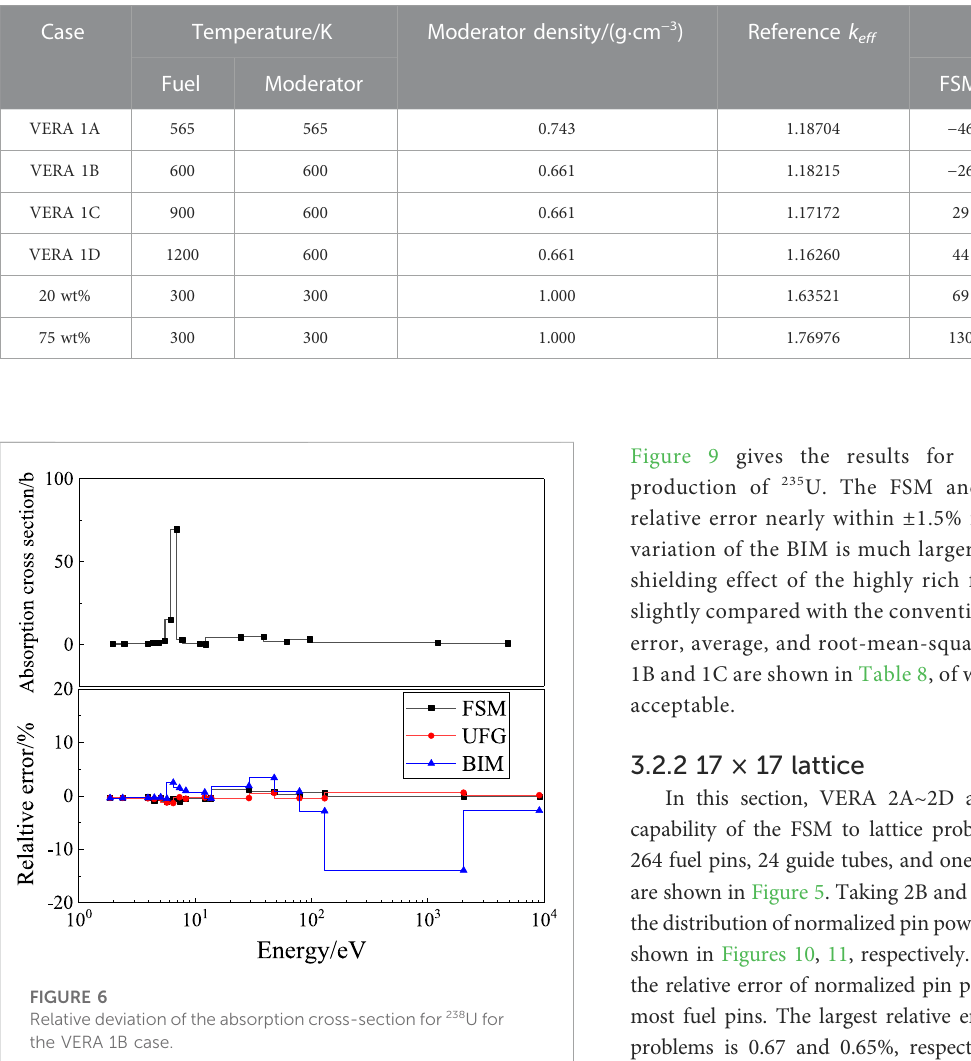
TABLE 6 Calculation results of k eff for VERA single-cell problems.